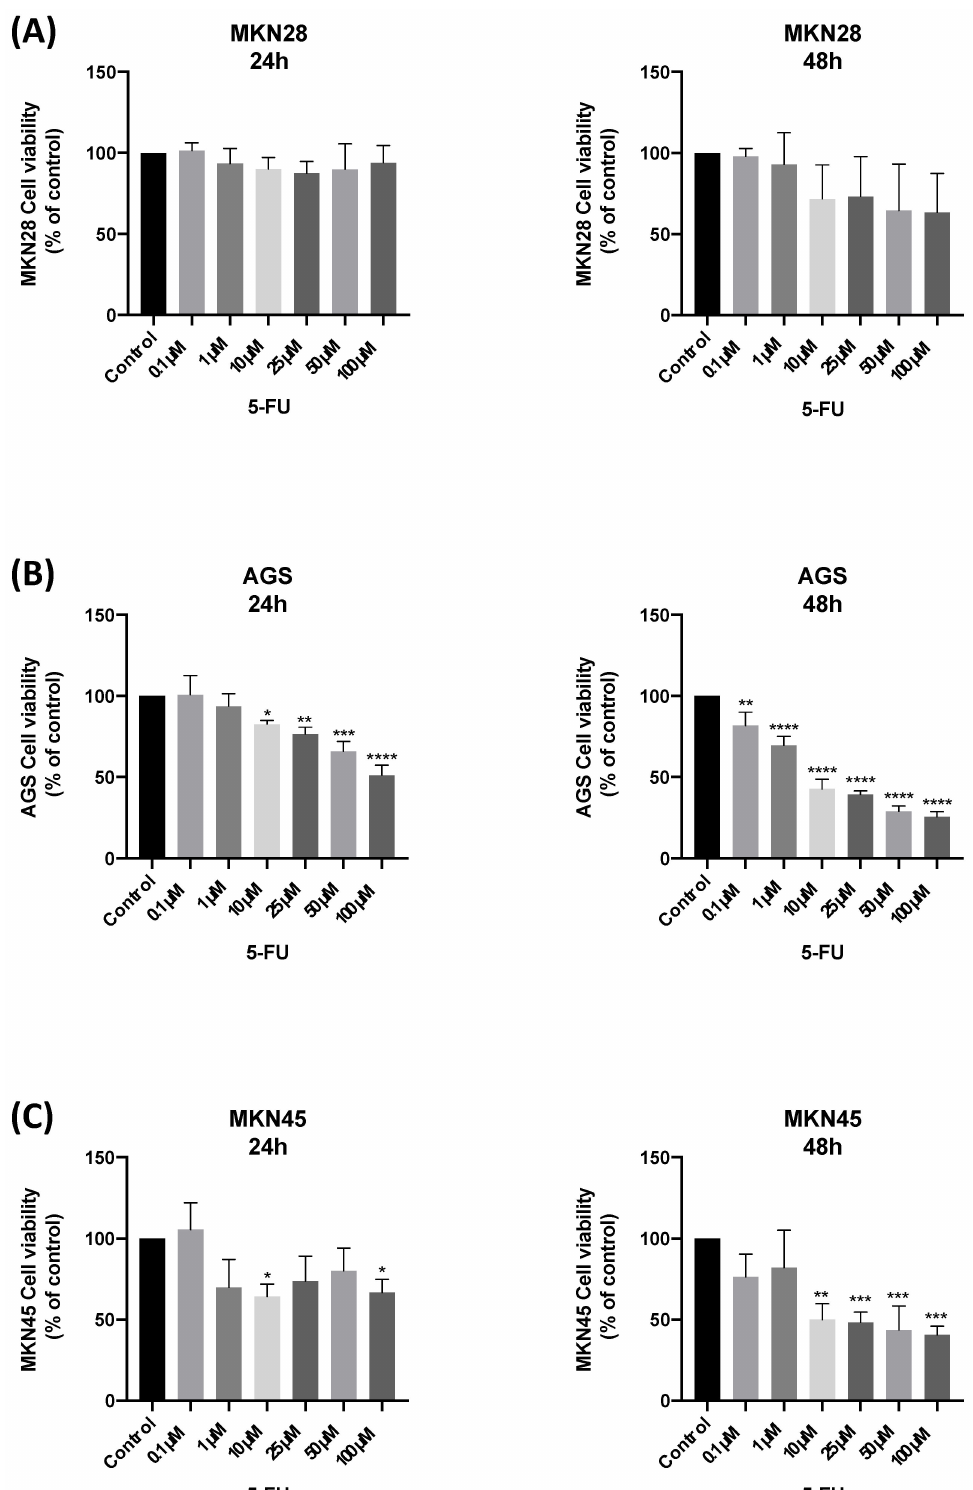
Figure 7. Viability of GC cells incubated with 5-FU. Cultured cells were seeded in 96-well plates and treated with 5-FU (0.1–100 µ M) for 24 and 48 h. (A ) The effect of 5-FU on MKN28 cell viability at 24 h and 48 h. ( B ) The effect of 5-FU on AGS cell viability at 24 h and 48 h. ( C ) The effect of 5-FU on MKN45 cell viability at 24 h and 48 h. Values are expressed as percentages of control and represent means ± SEM. Each experiment was done three times independently ( n = 3); * statistically significant vs. control at p < 0.05. ** Statistically significant vs. control at p < 0.01. *** Statistically significant vs. control at p < 0.001. **** Statistically significant vs. control at p <